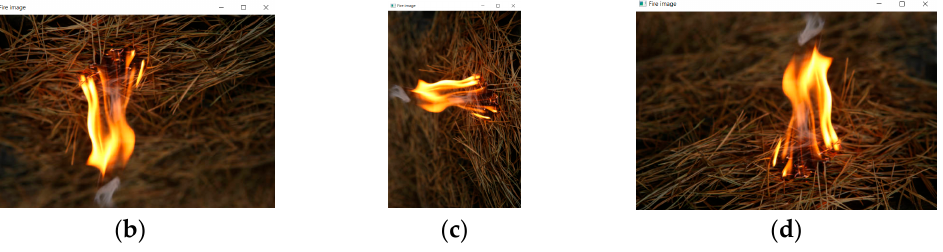
Figure 2. Example images of forest fire rotation from different angles. ( a ) 90° rotation; ( b ) 180° rota- tion, and ( c ) 270° rotation; ( d ) is the original image.